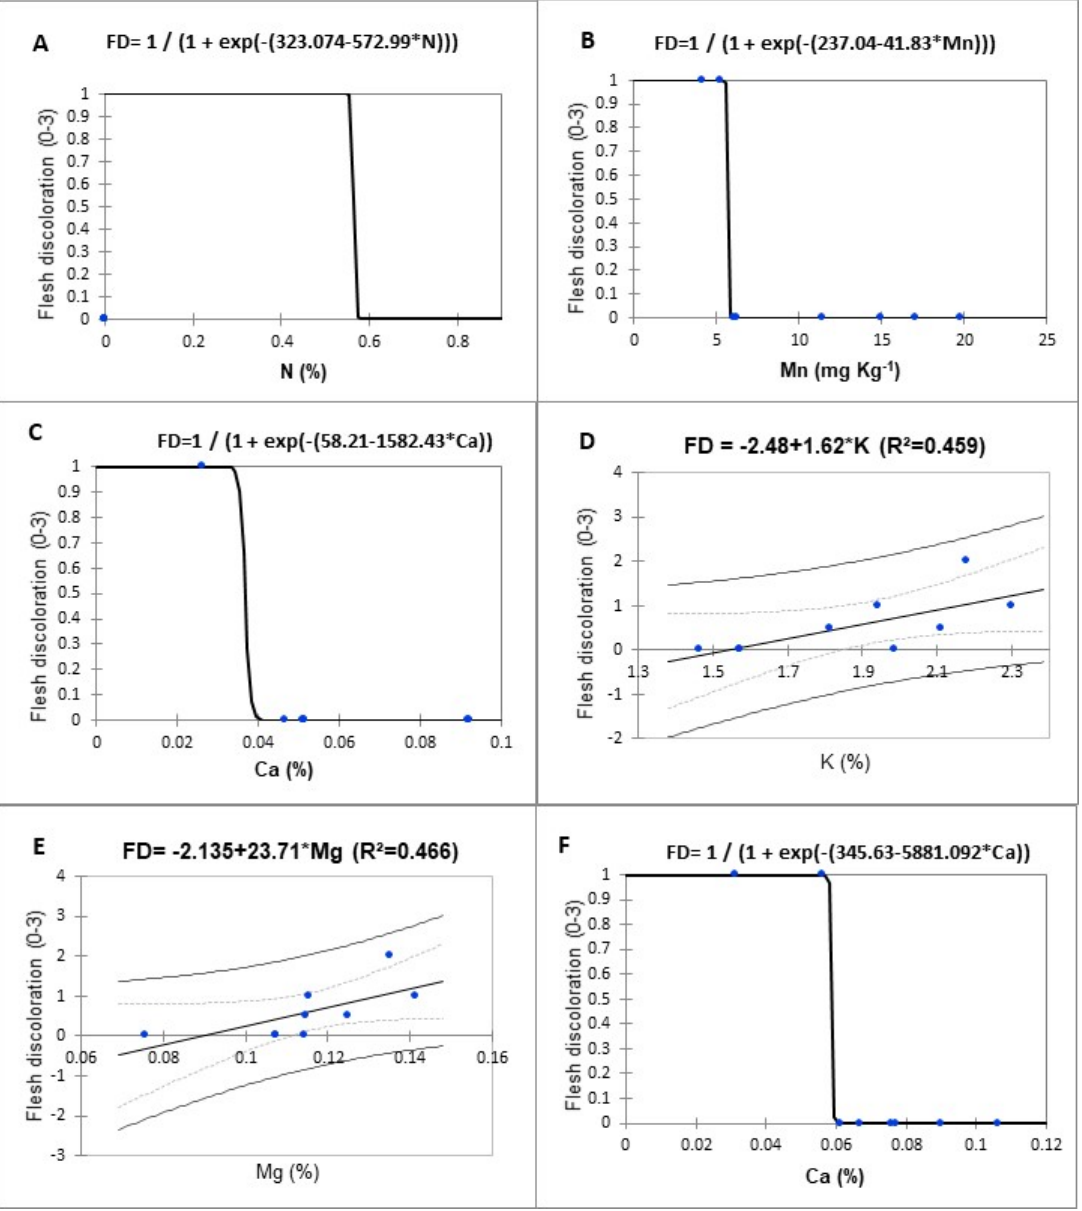
Figure 5. Mineral content and its relationship with flesh discoloration (FD): ( A,B ) EB farm (DM- 30, ST= 5 weeks) for N, and Mn Content. ( C ) Lineal regression CS farm (DM-30, 0 weeks) for Ca content. ( D,E ) CS farm, lineal regression (DM- 30, ST= 5 weeks) for K and Mg content. ( F ) CS farm (DM-22, ST= 5 weeks) for Ca content.